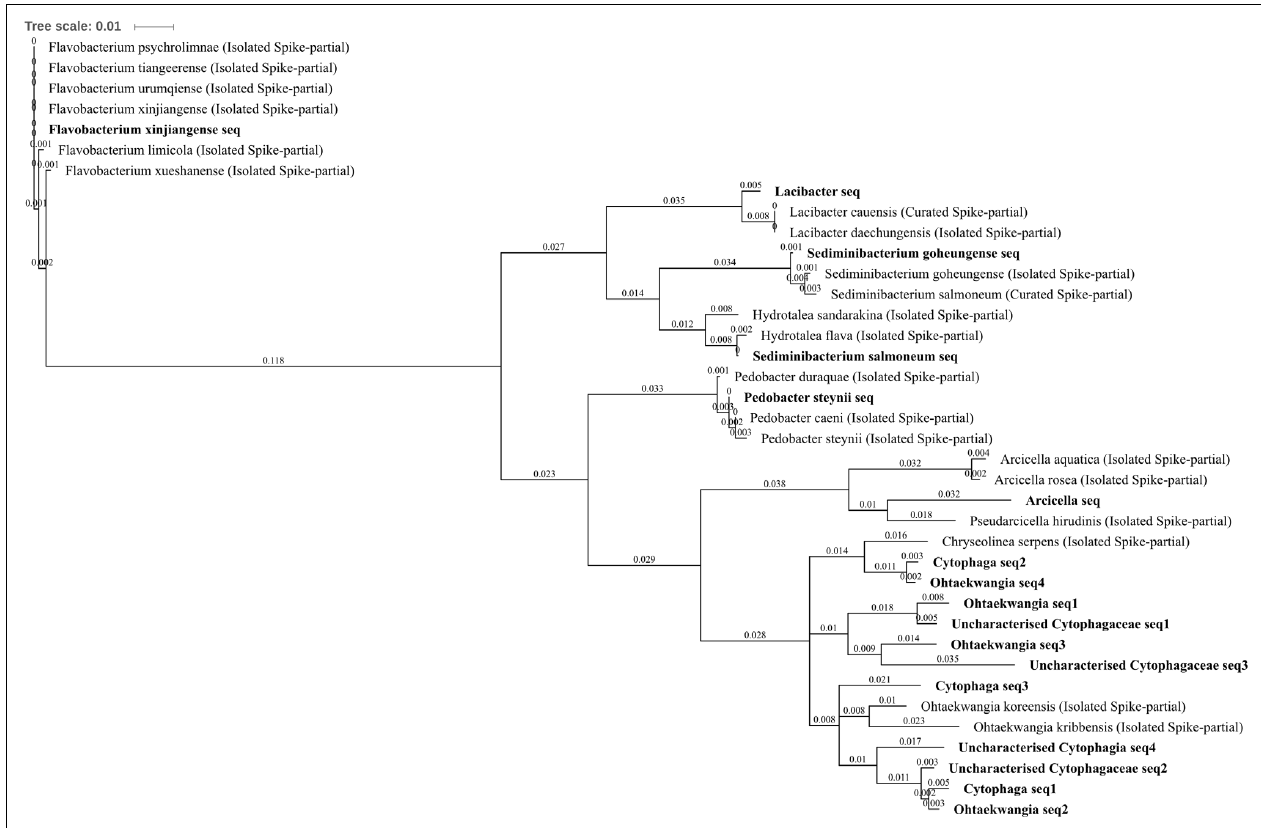
FIGURE 9 | Bacteroidetes phylogenetic tree. Jukes–Cantor model with neighbor-joining and > 50% support threshold (1,000 replications). Sub-OTUs (distinct amplicons) are highlighted in bold with spike (into the tree) sequences included as the most similar hits from the NCBI bacteria and archaea 16S rRNA gene database. All accession numbers and sequences (sub-OTUs and tree spikes) are provided in Supplementary File 2 . The value “0.01” on the scale bar represents 1 substitution in 100